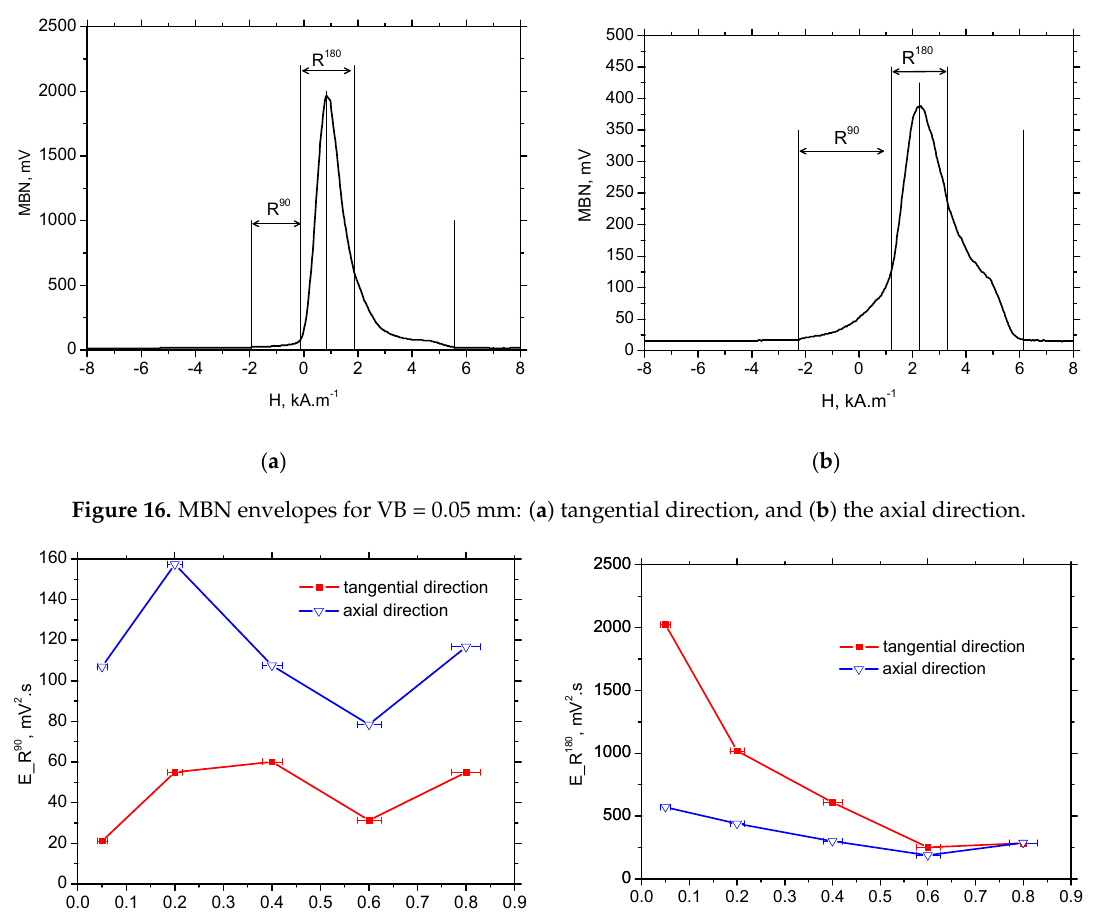
Figure 16. MBN envelopes for VB = 0.05 mm: ( a ) tangential direction, and ( b ) the axial direction.